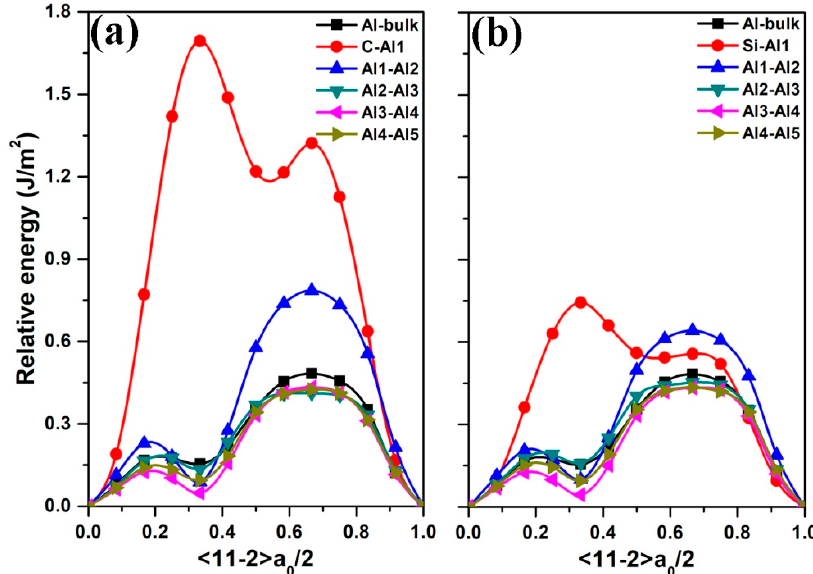
Figure 5. The generalized stacking fault (GSF) energy curves for displacements in the (111) plane along the <11-2> direction of different dissociation surfaces of the C-terminated ( a ) and Si-terminated ( b ) Al (111)/6H-SiC (0001) interfaces. C-Al1 represents the cleavage plane between C and Al1 atomic layers, as shown in Figure 2. The same is true of other situations. For comparison, the generalized stacking fault (GSF) energy curves of bulk Al is also shown here. a 0 is the lattice constant of Al.